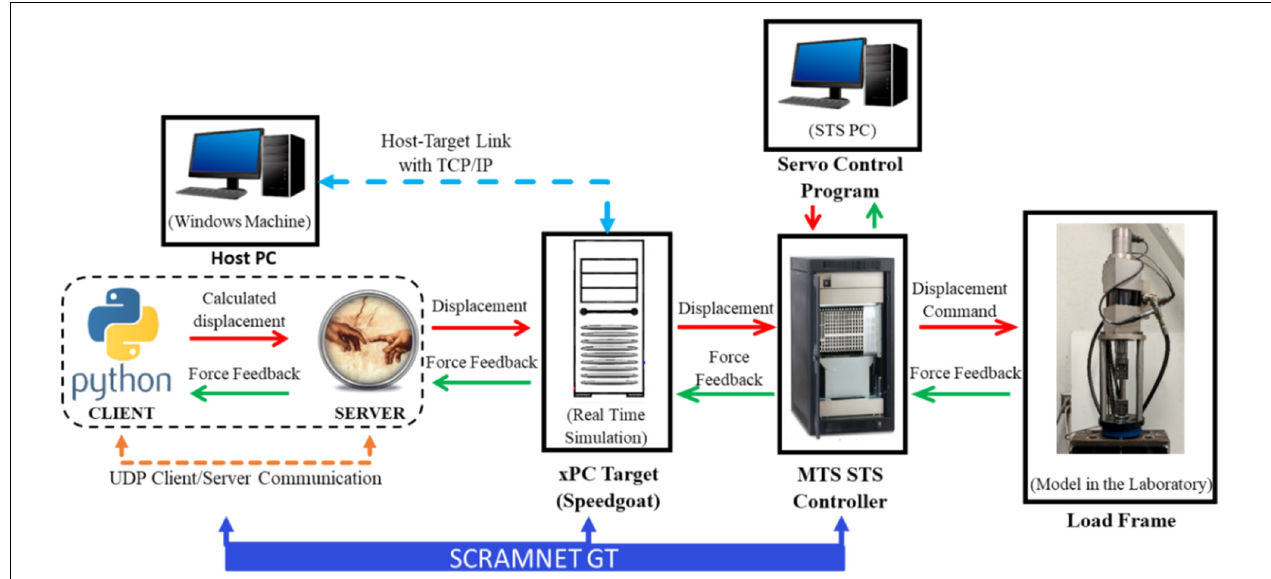
FIGURE 12 | HS/RTHS communication details for Python-based analytical substructure (metamodel) located and called from local